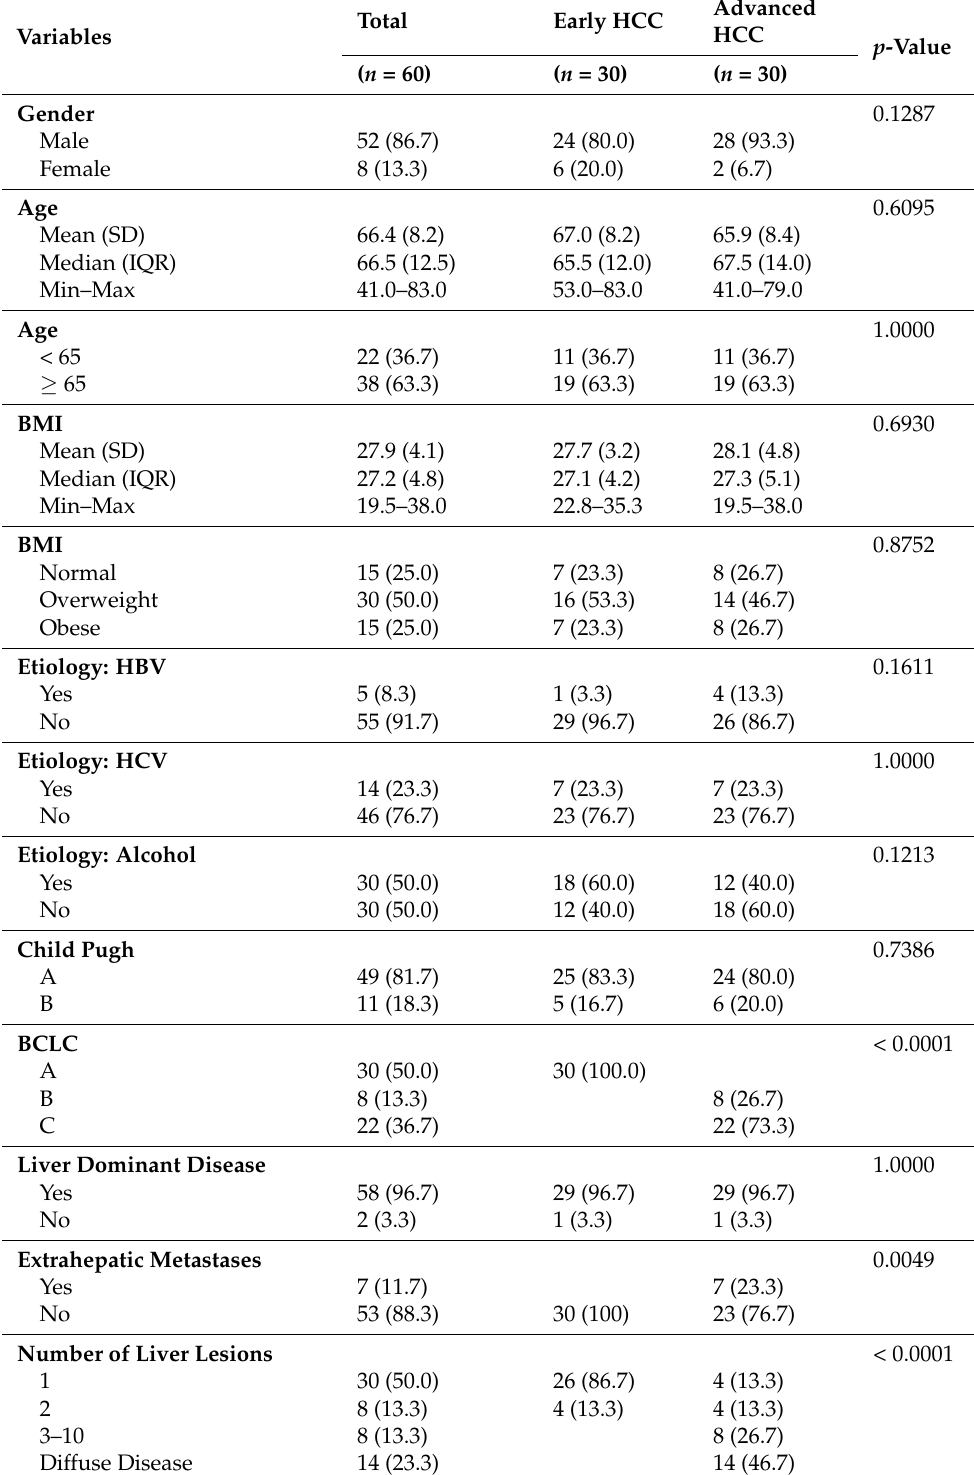
Table 2. Baseline characteristics of all included patients with an advanced HCC ( n = 30) and an early HCC ( n = 30). The mean values and standard deviations (SD, in parentheses) as well as p -values are displayed. ALBI = albumin-bilirubin; BCLC = Barcelona Clinic liver cancer staging